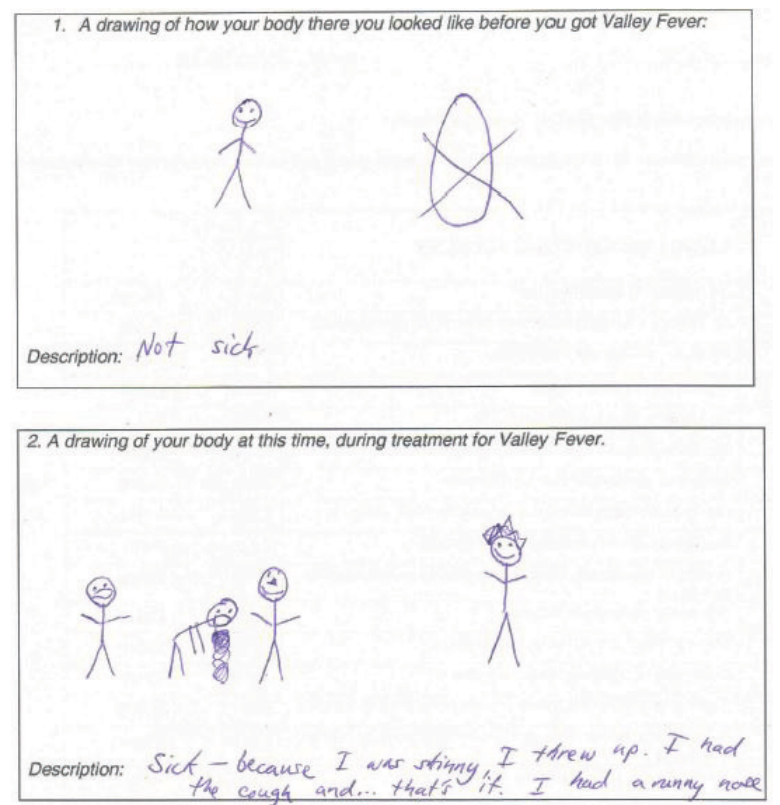
Figure 3. Drawing of a child with coccidioidomycosis with a focus on physical symptoms.